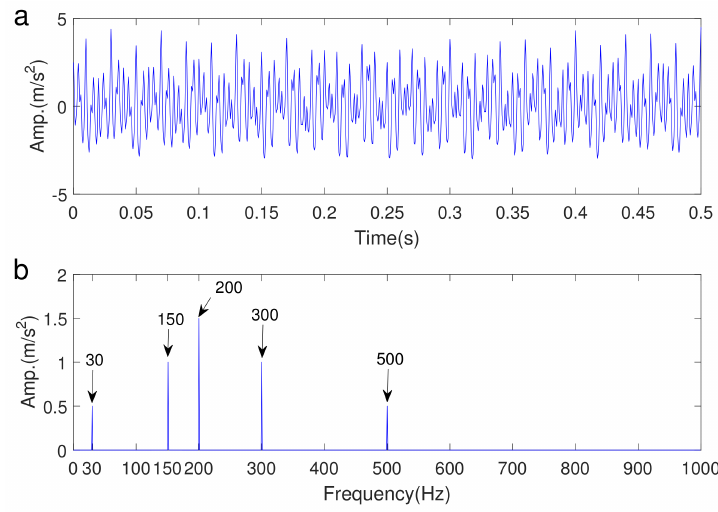
Figure 2. The simulated multi-harmonic signal: ( a ) temporal waveform ( b ) its Fast Fourier Transform (FFT)